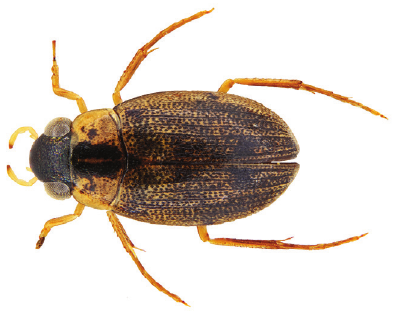
Figure 15. Berosus viticollis Boheman, 1851 2.8 mm, iSimangaliso Wetland Park, False Bay (site 29), February 2015 DT Bilton, MS Bird & R Perissinotto